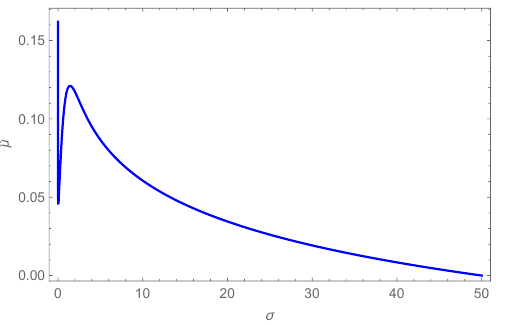
Figure 4 . The coupling constant µ as the function of the parameter σ . The non-monotonicity is shown explicitly. In this plot, q = 50 , J = 1 , and T s = 0 . 000753